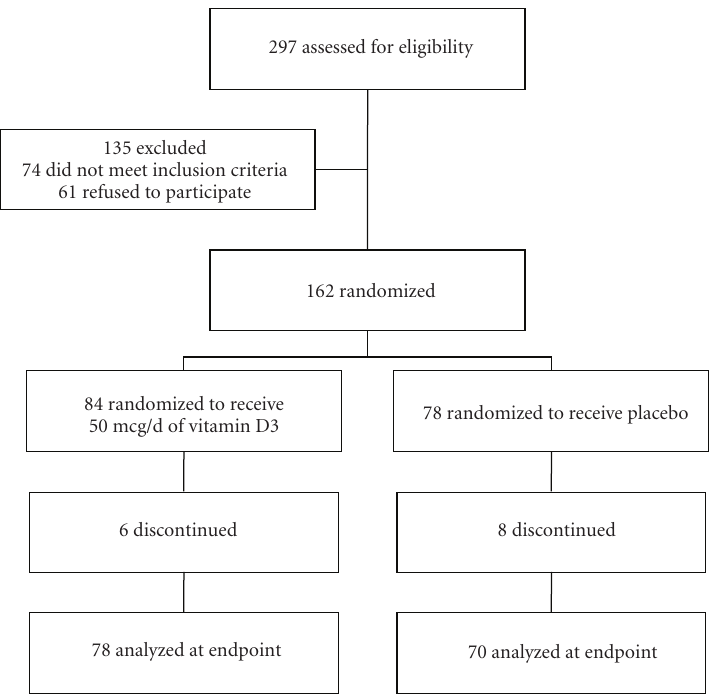
Figure 1: Epidemiology and Infection, Volume 137, Issue 3, 2009 “A randomized controlled trial of vitamin D3 supplementation for the prevention of symptomatic upper respiratory tract infections” by John Aloia. c (cid:2) 2009 Cambridge University